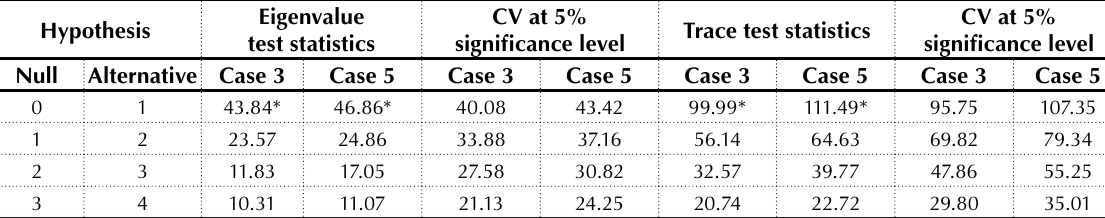
Table 3. Johansen cointegration rank test results